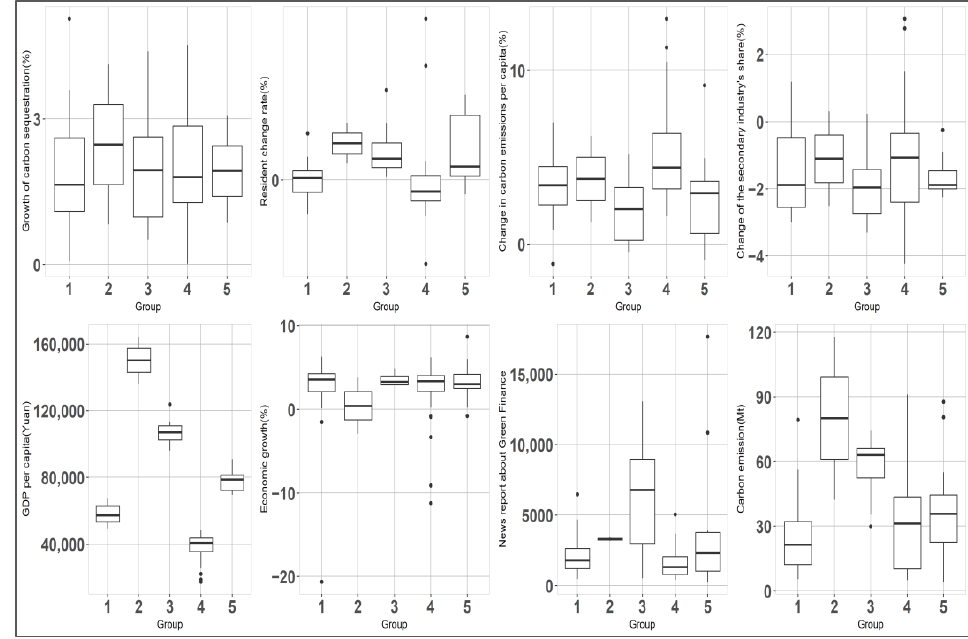
Figure 6. Key features of different categories of cities.